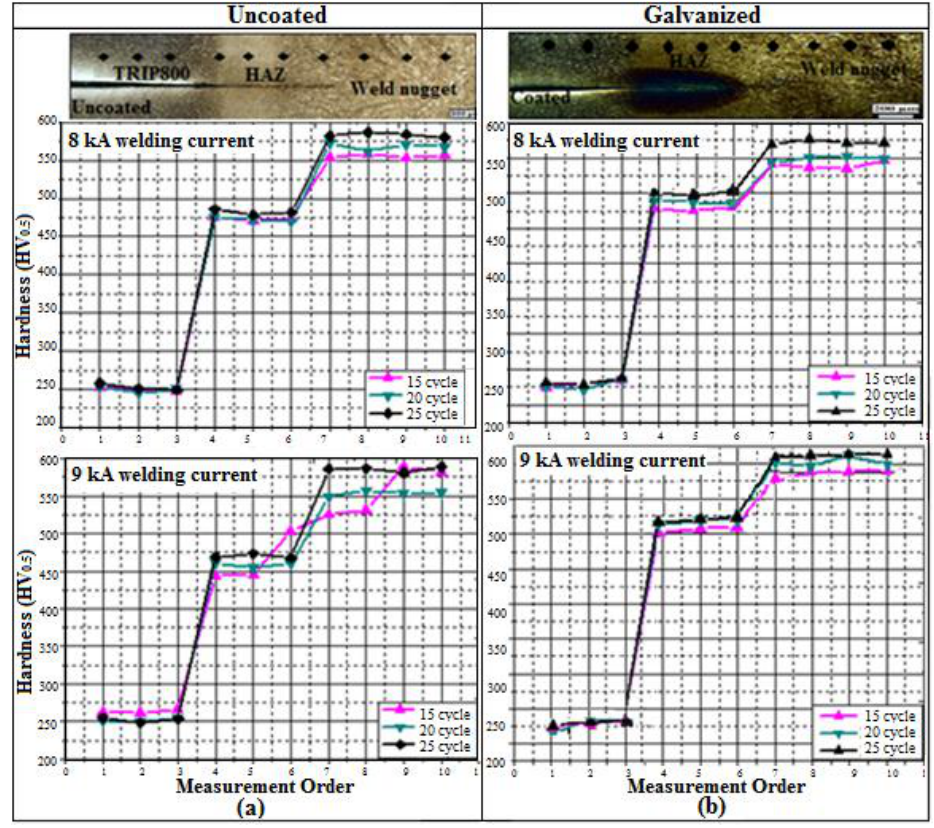
Figure 8. Hardness measurement of samples: ( a ) uncoated; ( b ) galvanized.